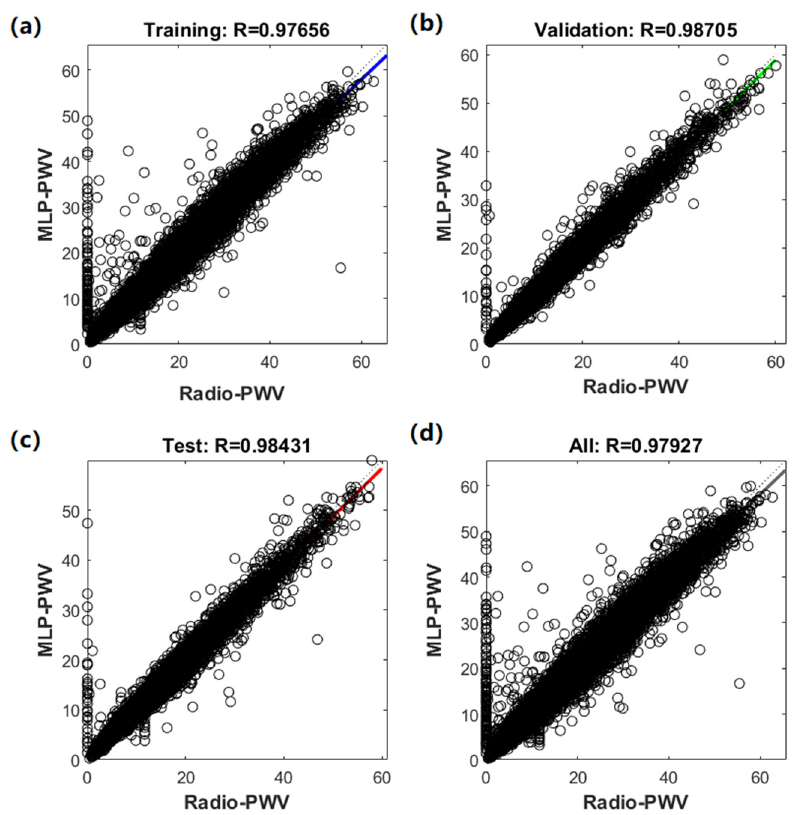
Figure 4. Learning effect of multilayer perceptron (MLP) neural network (the horizontal axis is the PWV of the radiosonde station, the vertical axis is the PWV of machine learning, and the oblique line is the fitting line).